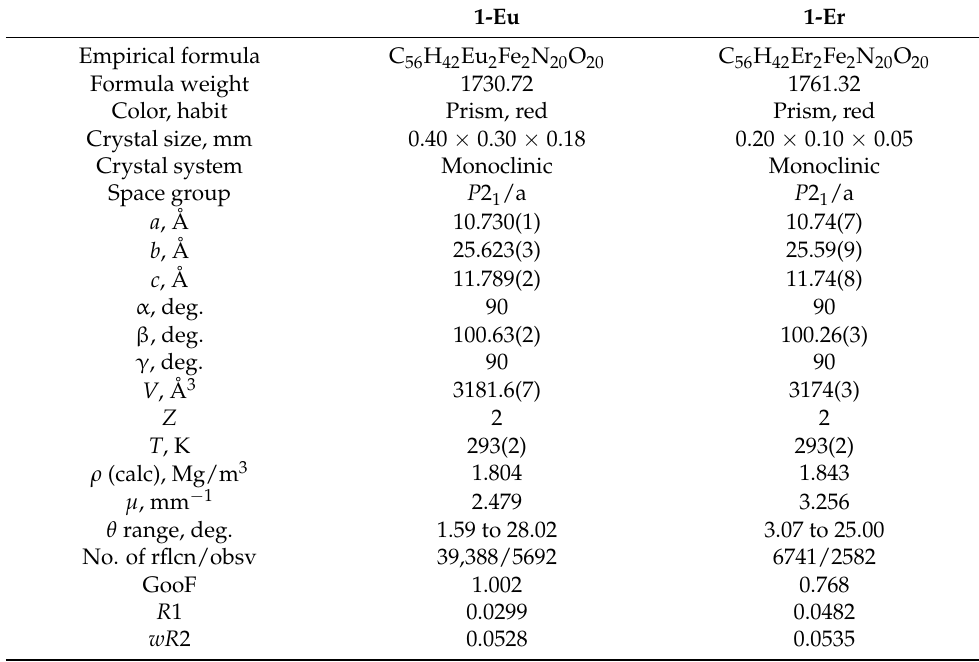
Table 2. Summary of X-ray crystallographic data for 2 -Ln.